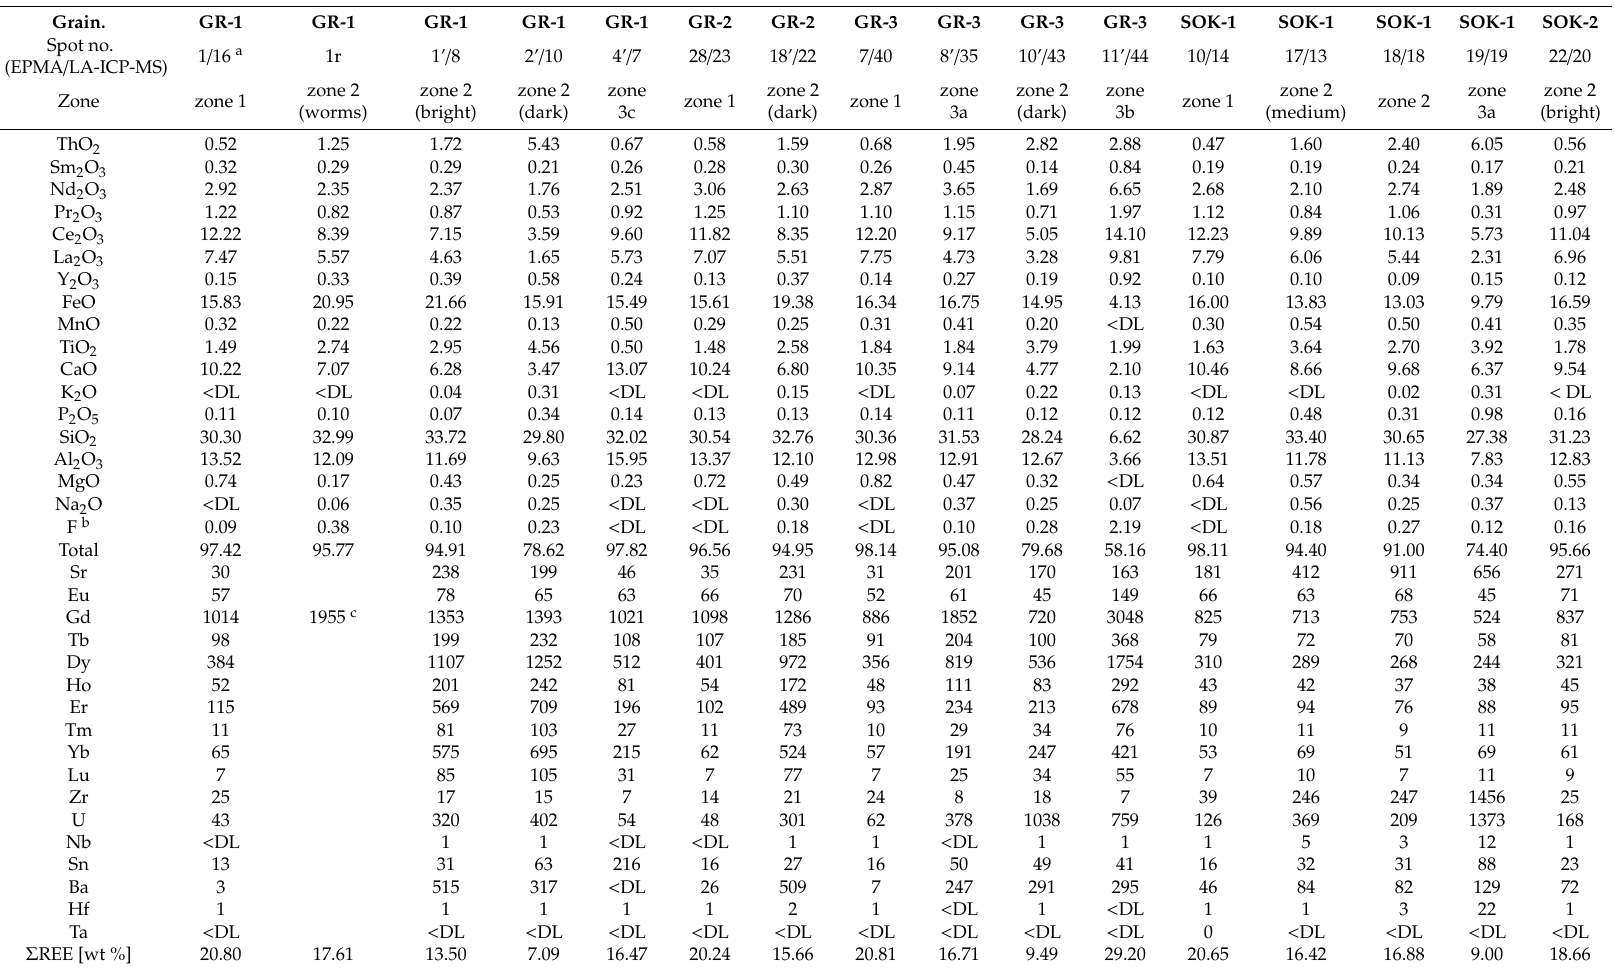
Table 1. Chemical composition (EPMA + LA-ICP-MS) of selected zones in all studied allanite